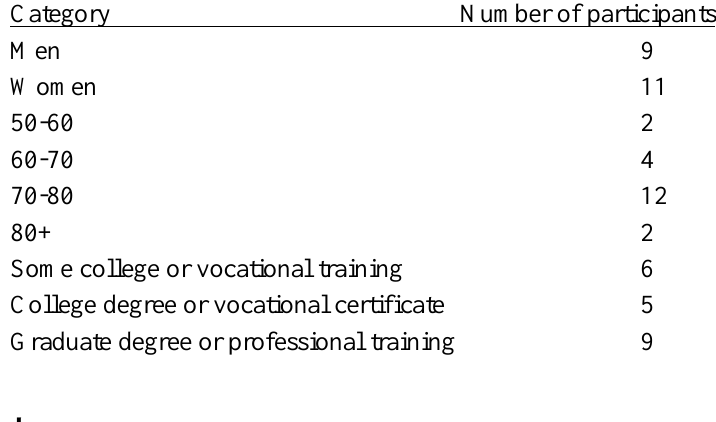
Age and Gender of